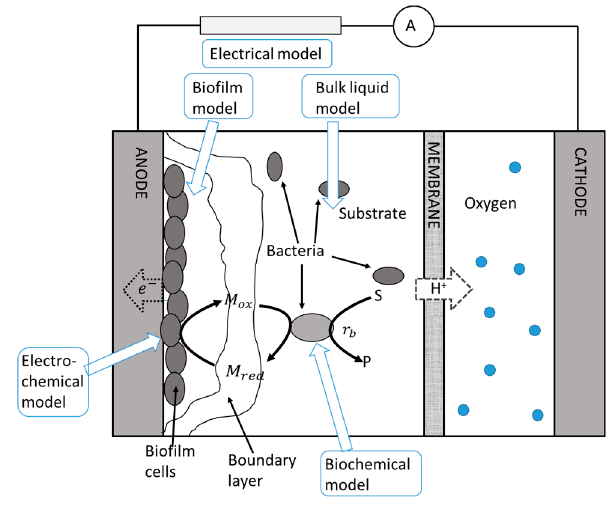
Figure 8. Integration of multiple models for comprehensive description of MFCs (redrawn from [41]).